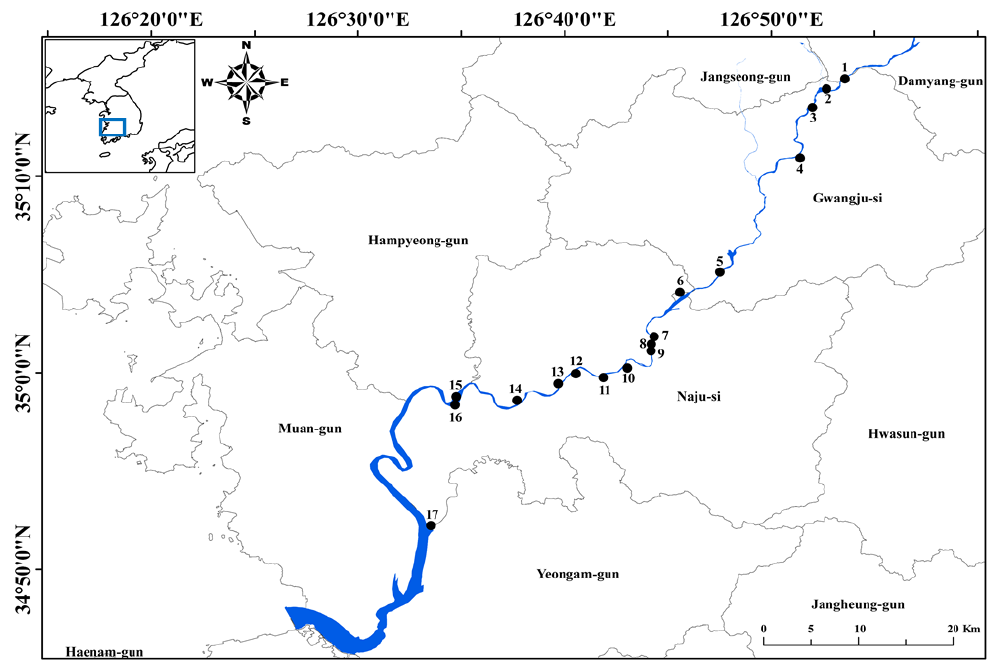
Figure 1. Map showing the 17 study sites located in southeastern South Korea. The study sites are indicated by solid circles ( • ). The small map in the upper left corner shows the Korean Peninsula.